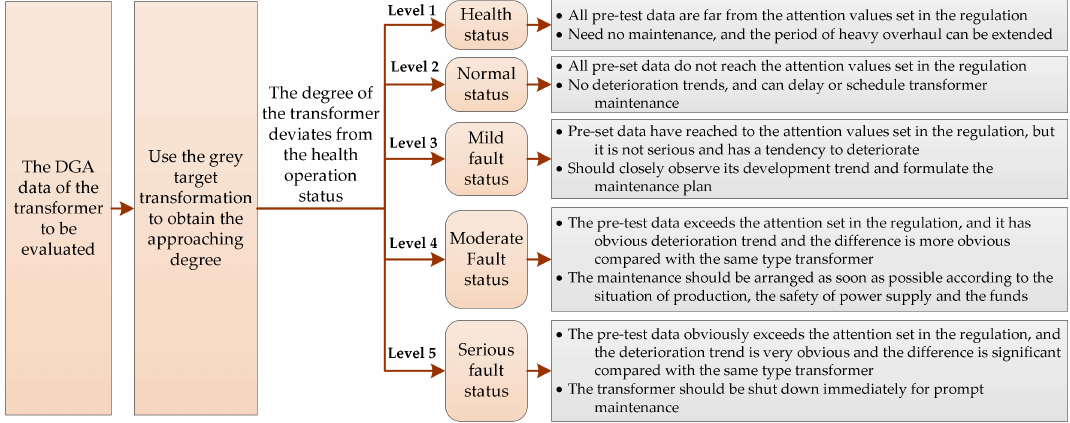
Figure 6. The grading of operation status of the